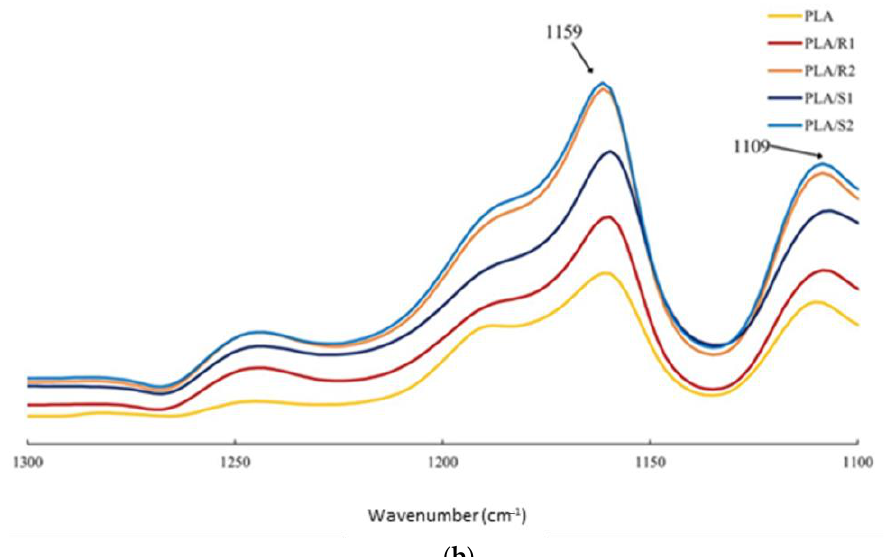
Figure 5. FTIR Spectrum of PLA, PLA/R1, PLA/R2, PLA/S1 and PLA/S2 ( a ) 400 – 4000 cm − 1 region and ( b ) 2800 – 300 cm − 1